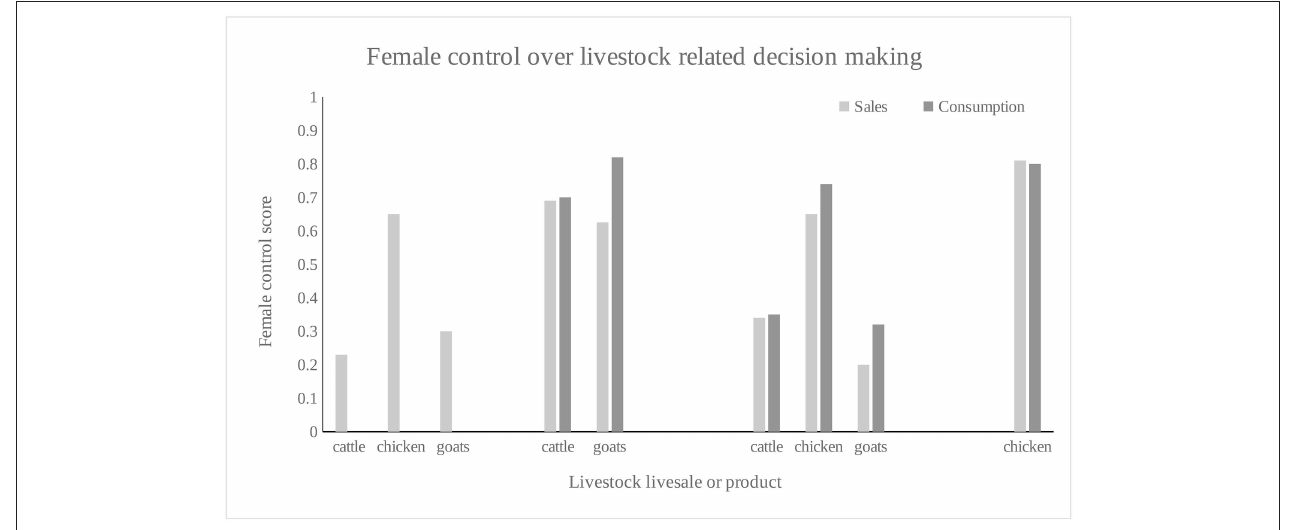
FIGURE 3 | Female control over livestock-related decision making across all systems and gender-respondent-household typologies.